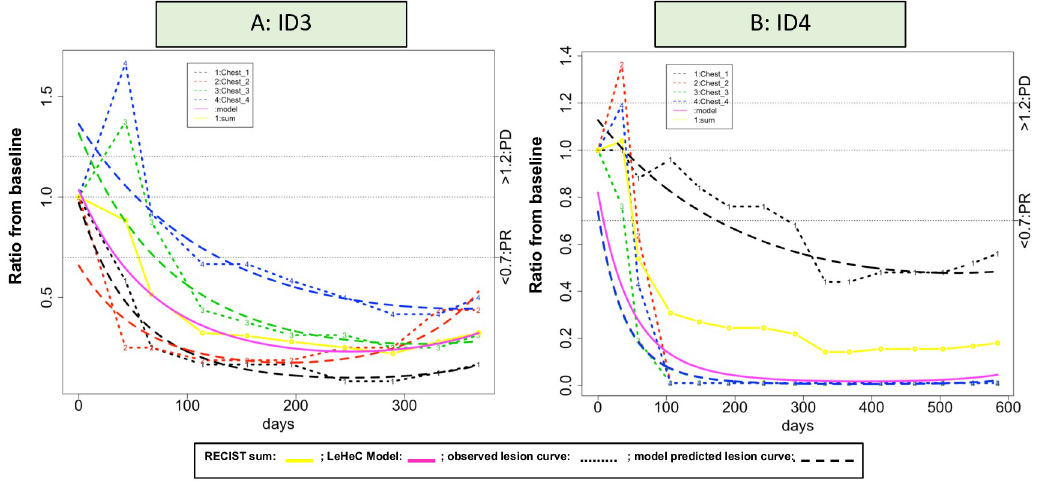
Fig 6. Mix of pseudo-progressive and regressive lesions. (A): Case ID 3 had 4 chest lesions with two chest lesions (lesion 3-4) experienced early progression and then developed response with a ratio below 0.7 after day 100. The other two chest lesions had a ratio below 0.7 after the 1 st CT scan. (B): Case ID 4 had a similar pattern where an initial ratio > 1.2 and then disappeared after 100 days in two upper lobe nodule lesions (lesion 2 and 4). The two lower lobe nodule lesions had tumor reduction at least 30% with one after day 100 and the other one after day